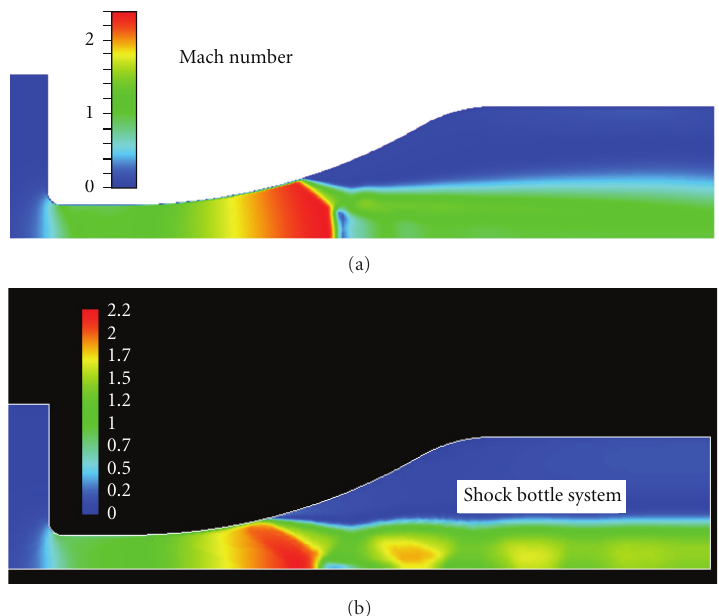
Figure 2: Transonic nozzle simulations for typical di ff user geometries for (a) non-conservative method and (b) conservative